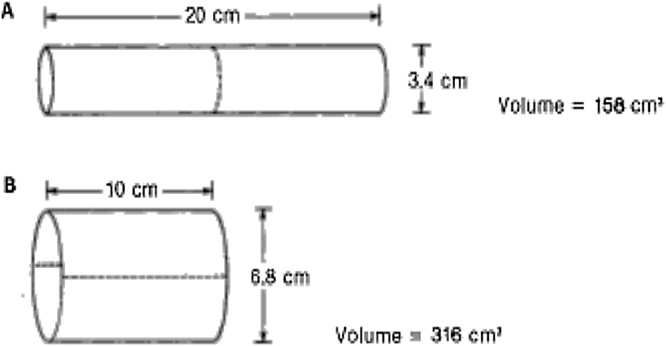
Comparison of the tube capacity calculation with a length of 20 cm and a diameter of 3.4 cm (175cm2) and on the same tube that is opened and folded lengthwise with a length of 10 cm and a diameter of 6.8 cm (316 cm2) [15].